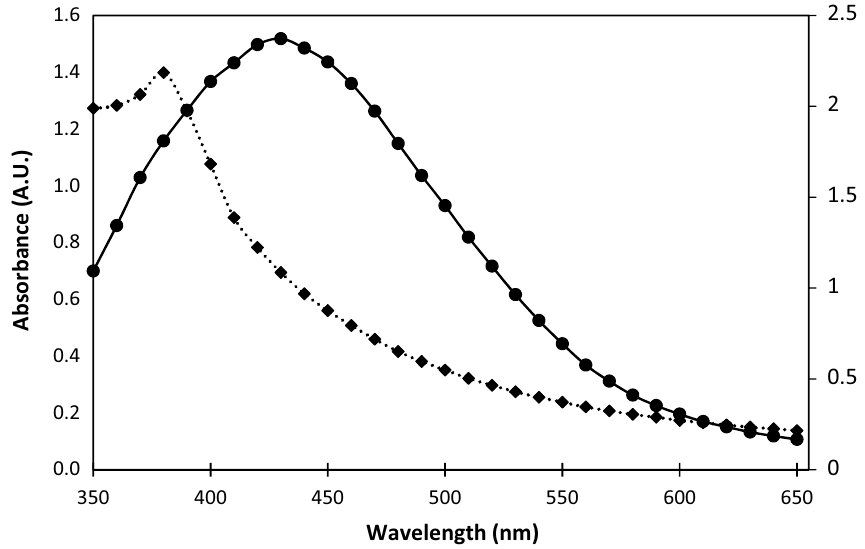
Figure 2. UV–Vis. spectrum of green synthesized AgNPs (solid line) showing a peak absorbance at 430 nm and of PGLE (dotted line) showing a peak at 380